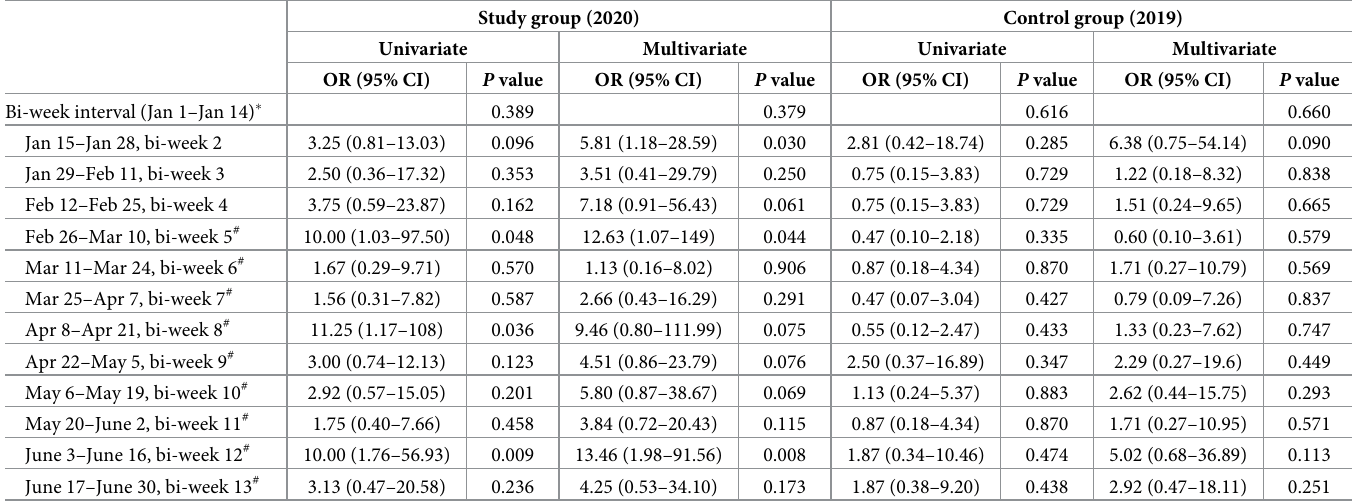
Table 2. Univariate and multivariate logistic regression analyses of odds ratios for uncomplicated and complicated appendicitis (vs. normal and mild appendicitis).